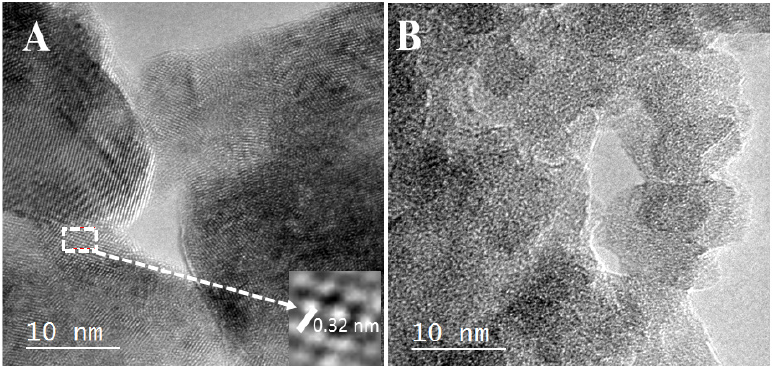
Figure 3. High-resolution transmission electron microscopy (HRTEM) micrographs of ( A ) Nd 2 O 3 and ( B ) Al-Nd-15 binary oxide.